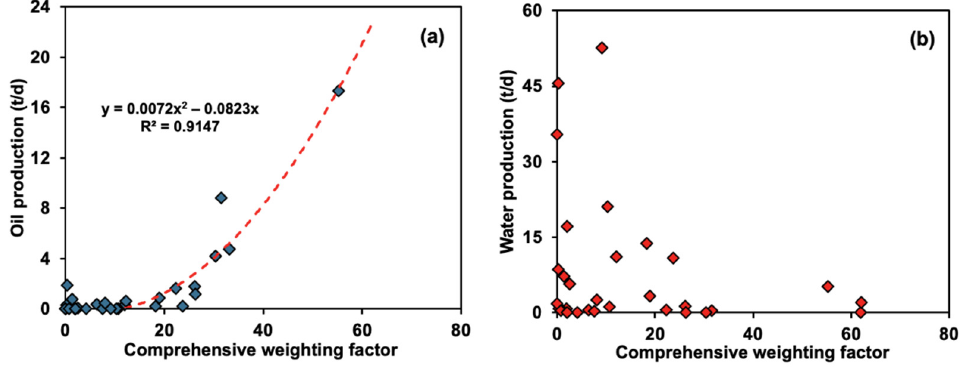
Figure 10. Relationships of initial oil ( a ) and water ( b ) production with the comprehensive weighting factor.